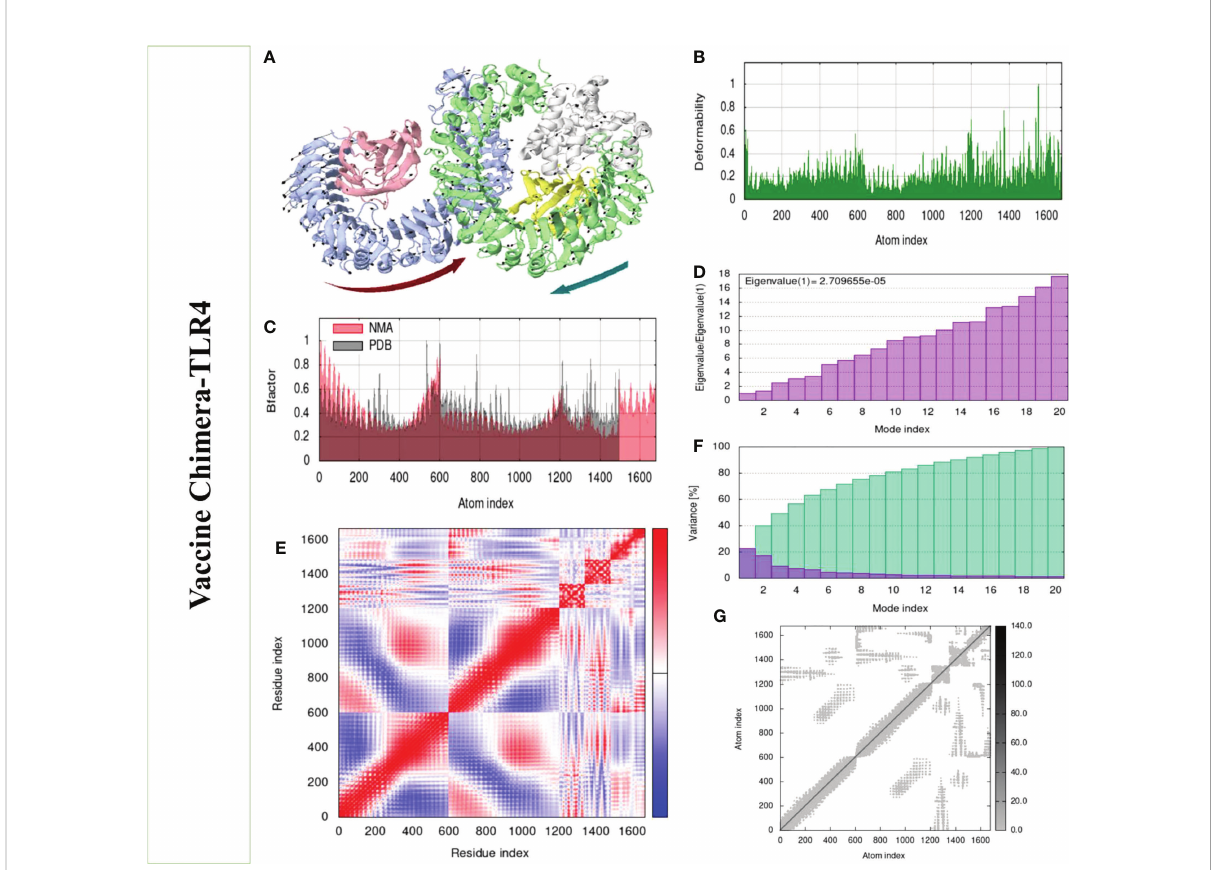
FIGURE 8 Normal mode analysis of the vaccine-TLR-4. (A) MOBILITY of re fi ned protein-protein complex. (B) In relation to atom deformability. (C) In relation to atom B factors. (D) Eigenvalue in relation to modes. (E) In relation to residue covariance. (F) Variance of structural changes. (G) In relation to atom elastic